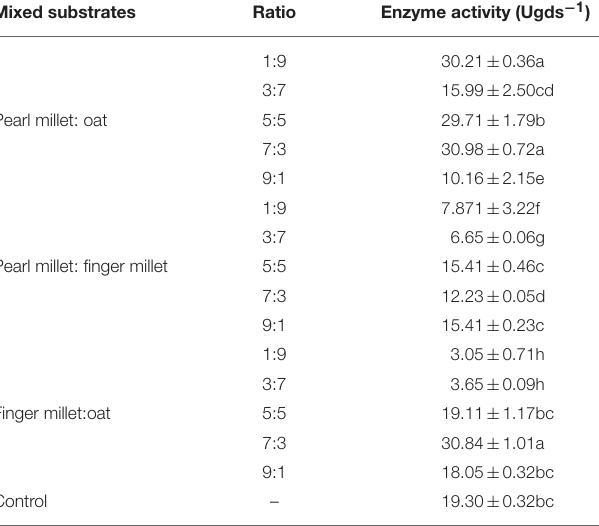
TABLE 4 | Effect of mixed agro-wastes on amylase